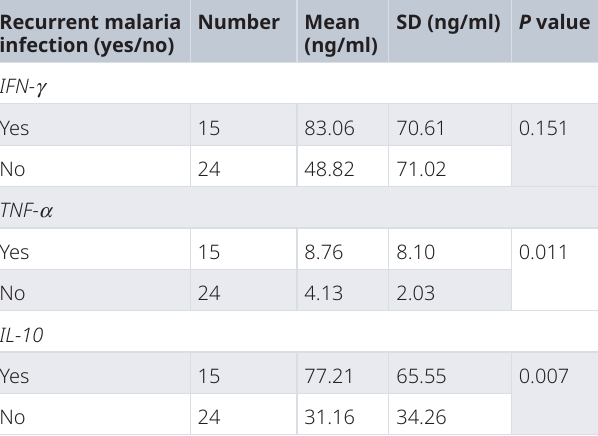
Table 7. Correlation between recurrent malaria infection and cytokine profiles.